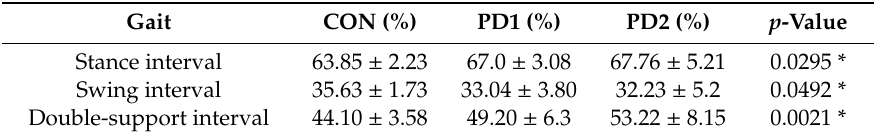
Table 4. Percentage of stance, swing, and double-support intervals when CON, PD1, and PD2 groups are